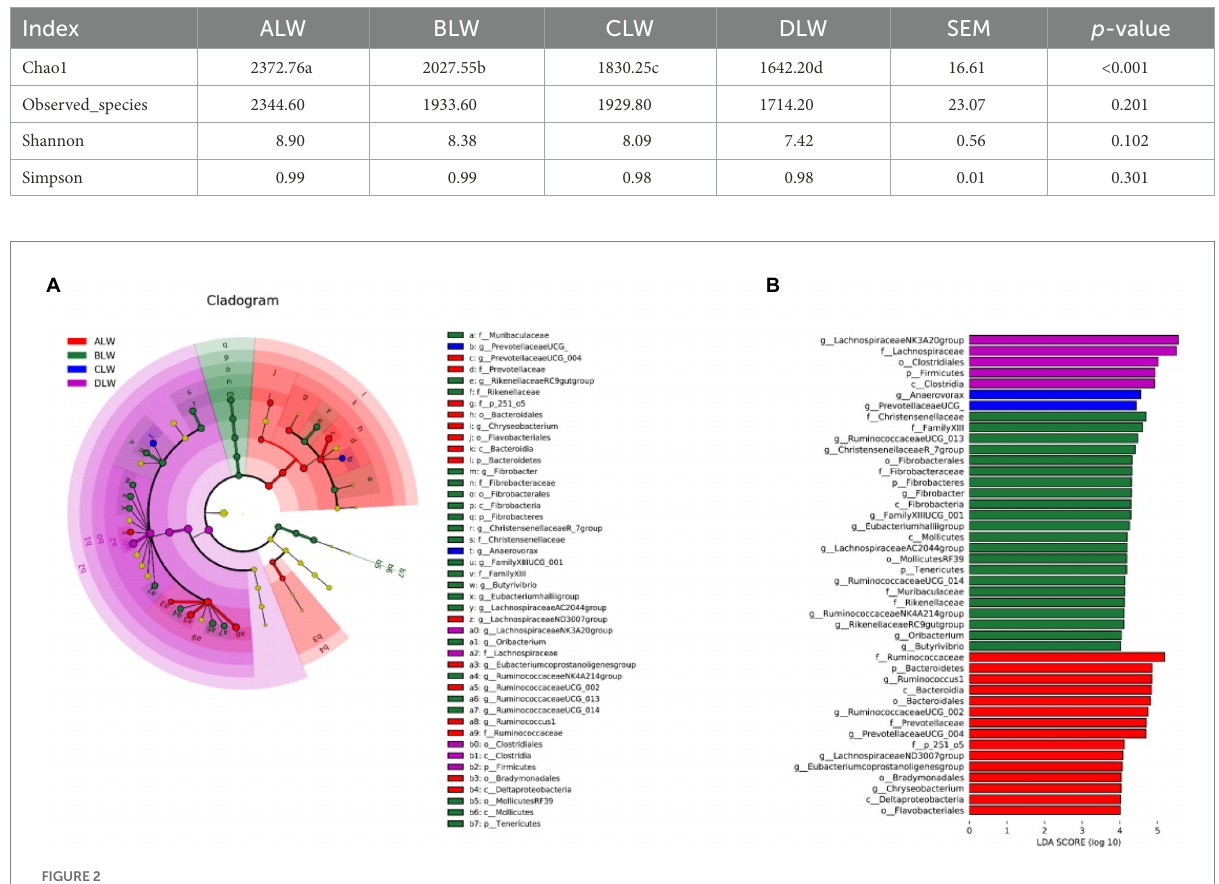
FIGURE 2 (A) Evolution cladogram (B) LDA score chart, LDA value >4, p <